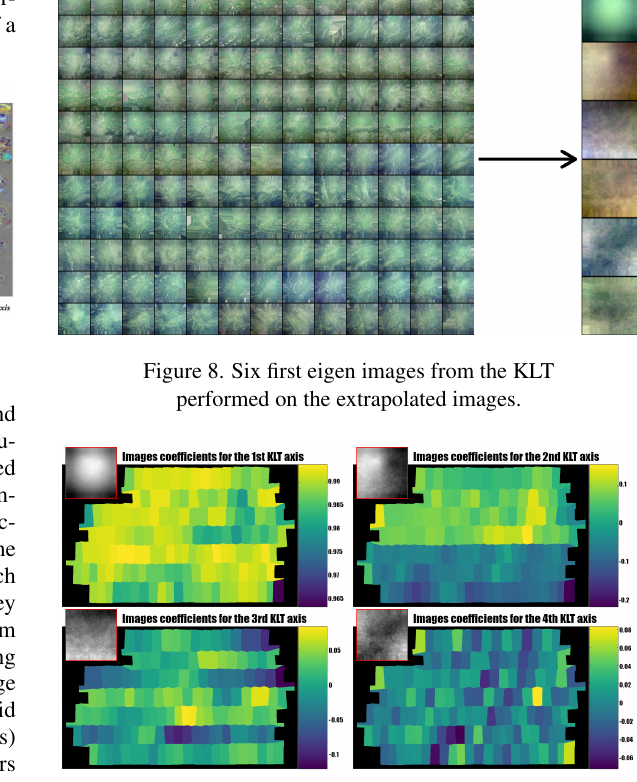
Figure 9. KLT coefficients for each images of the campaign.